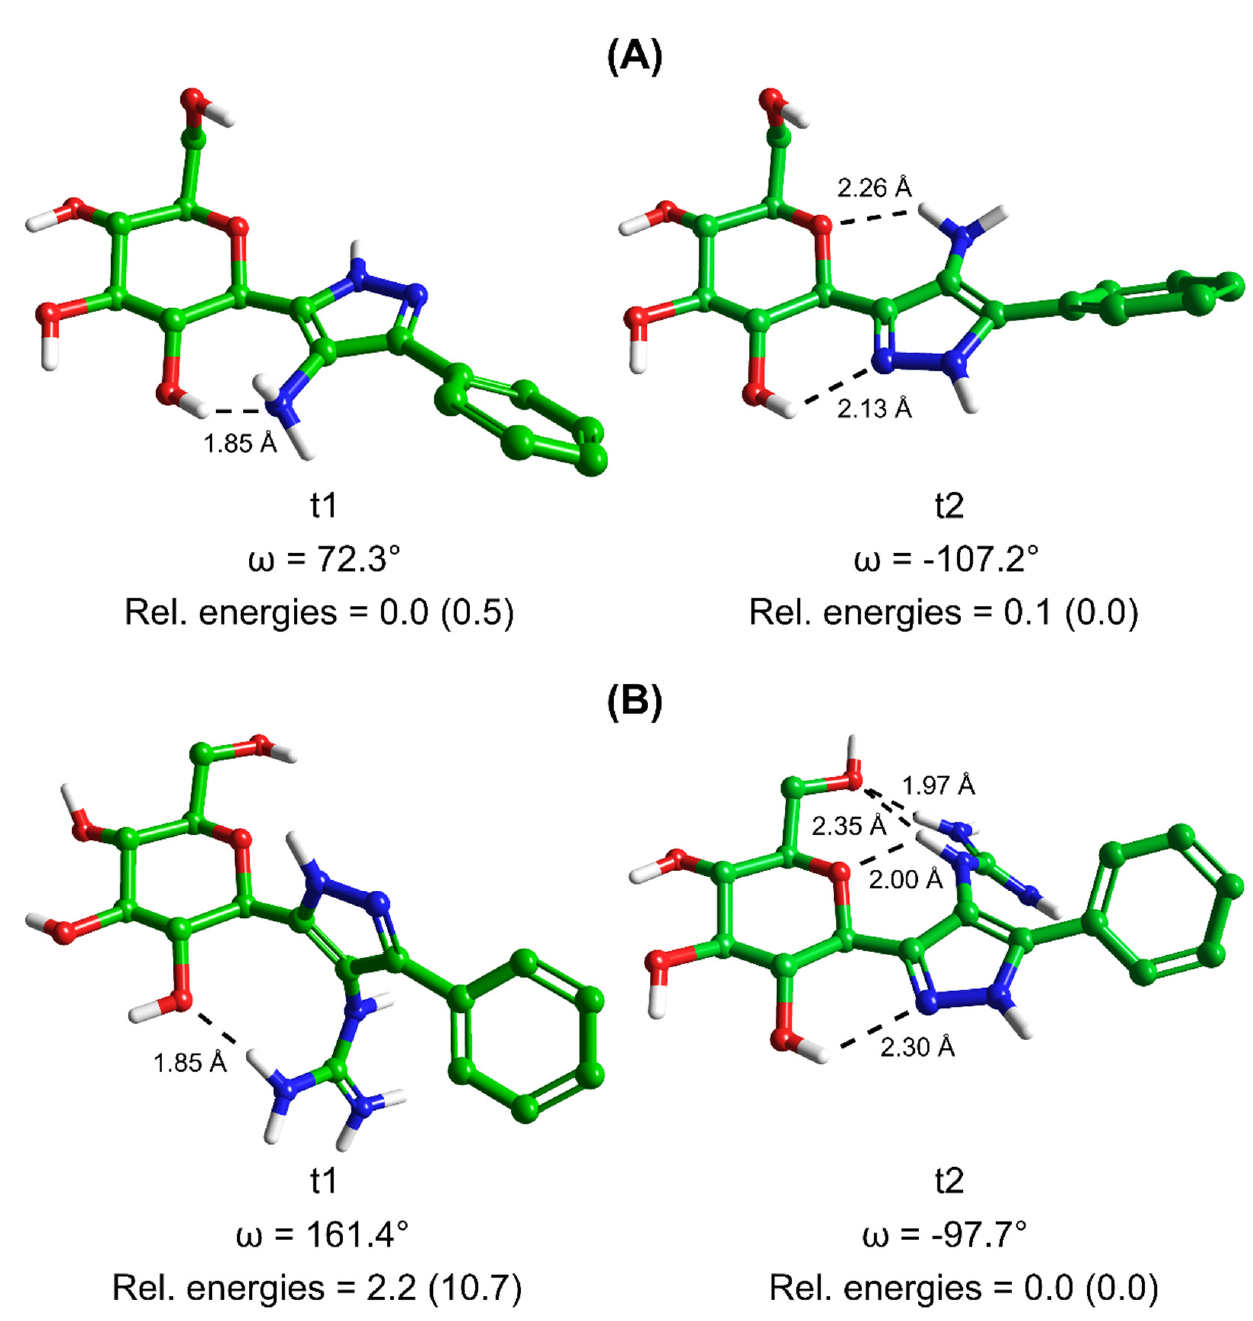
Figure 2. Predicted most stable conformations of tautomers 1 ( t1 ) and 2 ( t2 ) of compounds ( A ) 3 and ( B ) 4 ( c.f. Figure 1) in solution phase from Monte Carlo simulations post-processed by DFT calculations. Intramolecular hydrogen bond distances are given and shown as dashed lines, together with the dihedral angle value ω (as defined in Figure 1). The solution phase relative energies of the two tautomers of each ligand are listed, with gas phase relative energies in parentheses for comparison.